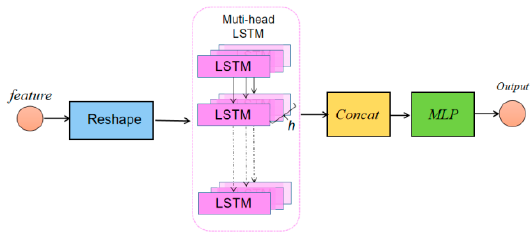
Figure 3. Structure of the multi-head-LSTM.